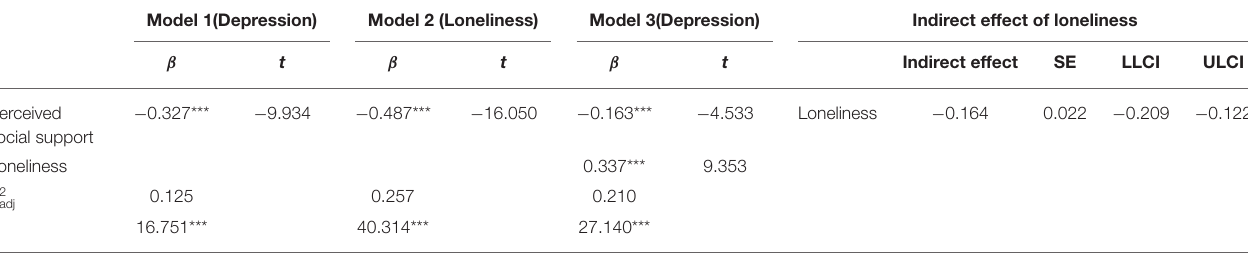
TABLE 4 | Mediation analysis ( N =